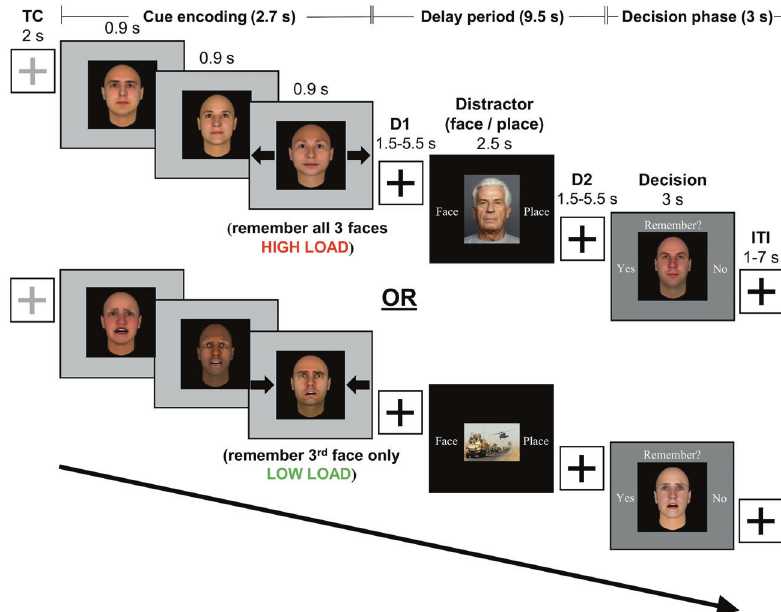
Fig. 1 Schematic diagram of the working memory task. During encoding, participants viewed three faces (cues) presented sequentially over 2.7 s. Upon the presentation of the third face, participants maintained either all three faces (high load, depicted in top row — i.e., arrows pointing outward) or the last face only (low load, depicted in bottom row — i.e., arrows pointing inward). After a jittered delay (D1) lasting 1.5, 3.5, or 5.5 s, subjects saw a distractor image for 2.5 s, during which time they made a button press to indicate whether the photograph showed a face or a place. After a second jittered delay (D2), subjects were presented with another face (decision) for 3 s, at which time they indicated whether they remembered it from the encoding period. A fi xation cross was then displayed for the 1 – 7 s inter-trial interval (ITI) that preceded the next